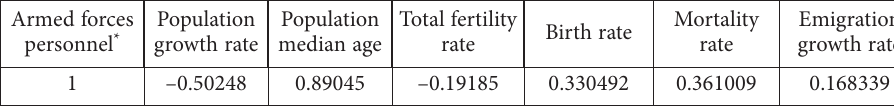
Table 1. Correlation coefficients between military and demography indicators (source: World Bank, 2019; Eurostat, 2019) Armed forces per sonnel *